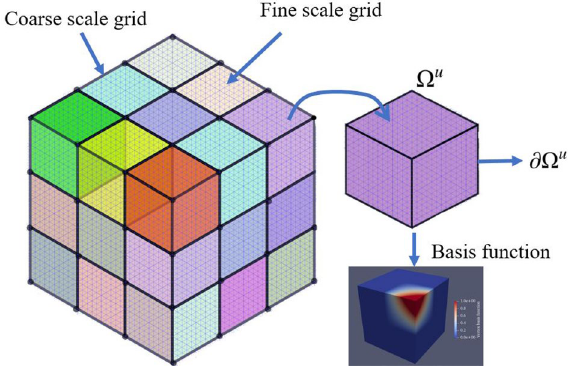
Figure 4. The above illustrates the 3D grid depicting finescale and coarse scale grid. Each coarse scale element ( (cid:31) u ) consists of fine-scale elements. The basis function of the corner coarse element is